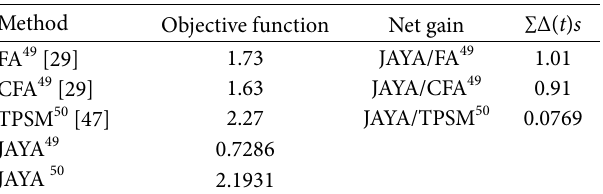
49, 50 represent the objective function mentioned in equations (49) and